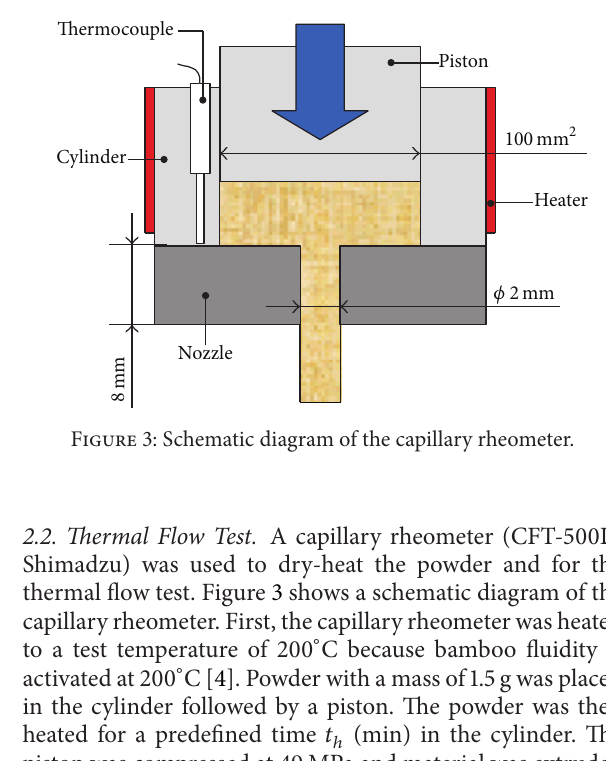
Figure 2: Schematic diagram of steam treatment.